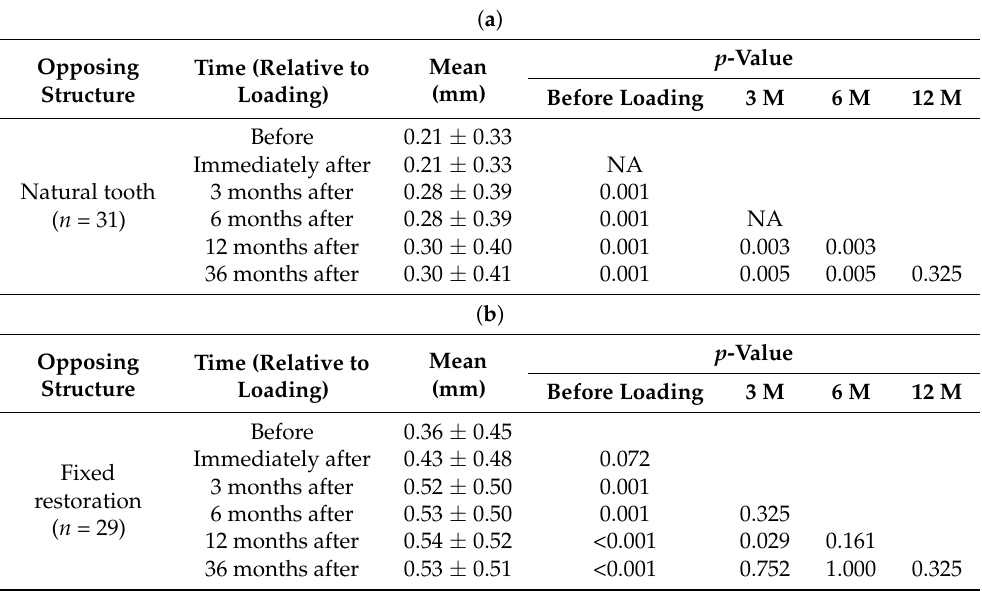
Table 2. ( a ) Analysis of marginal bone level with natural teeth in the opposing arch of the submerged dental implants. ( b ) Analysis of marginal bone level with fixed restorations in the opposing arch of the submerged dental